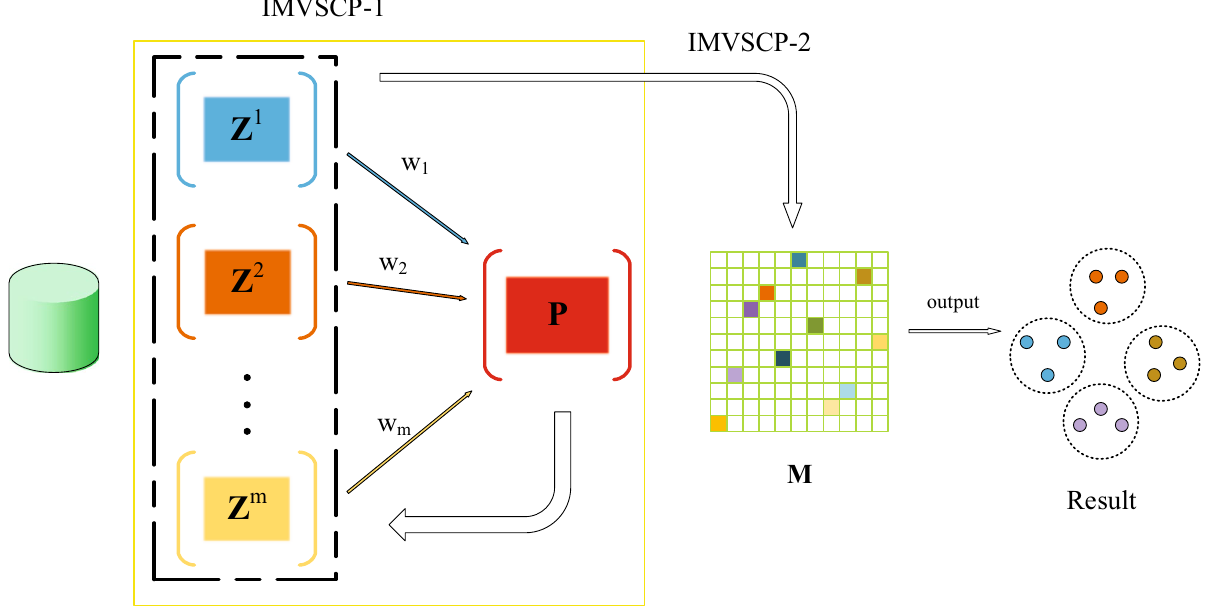
Figure 1. The basic process of IMVSCP algorithm is as follows: The IMVSCP algorithm is divided into two sub-algorithms, one is the IMVSCP-1 algorithm, and the other is the IMVSCP-2 algorithm. The IMVSCP-1 v ) m Z v ) m algorithm firstly obtains the similarity matrix ( Z v = 1 by K-nearest neighbor algorithm, and then fuses ( v = 1 into a unified matrix P by weighted fusion operation. In turn, the unified matrix P updates the similarity matrix for each view. IMVSCP-1 algorithm is an iterative updating process. The IMVSCP-2 algorithm takes the updated v ) m similarity matrix ( Z v = 1 obtained by the IMVSCP-1 algorithm as input, and combines the spectral clustering algorithm and symmetric non-negative matrix factorization algorithm to obtain the non-negative embedding matrix M , so as to directly output the clustering